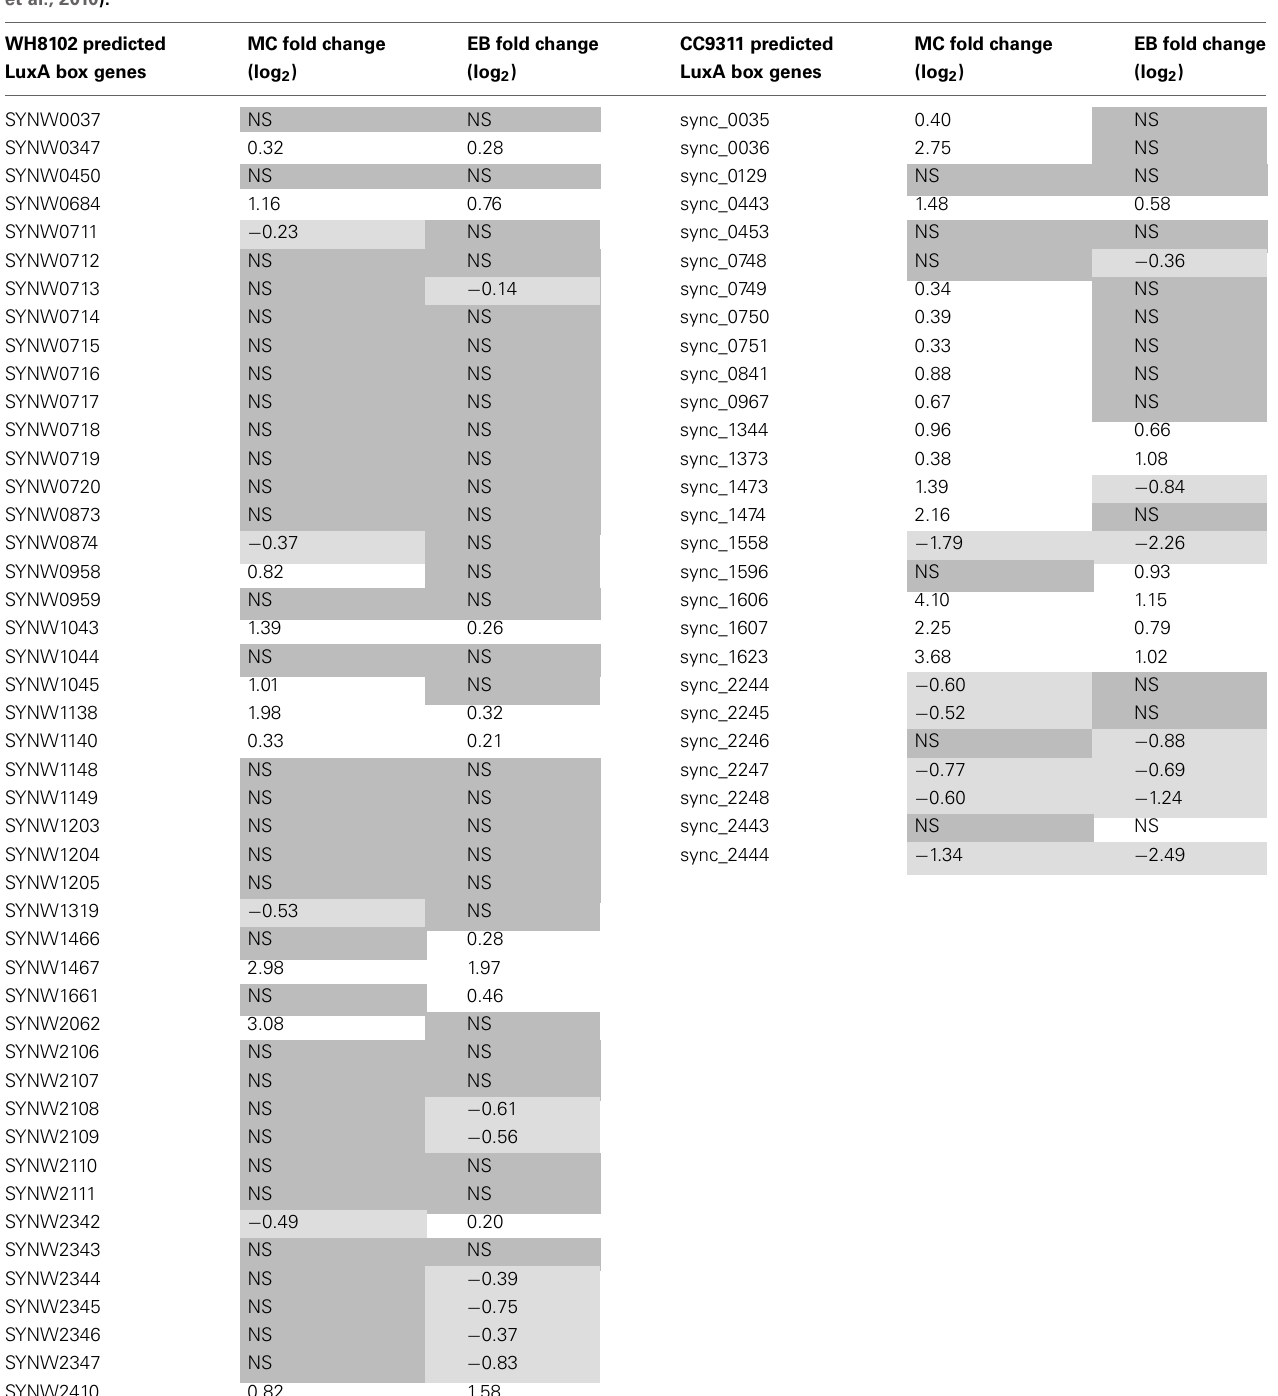
Table 4 | Transcriptional response of Synechococcus sp. WH8102 and CC9311 genes previously flagged as having predicted LexA boxes (Li et al.,